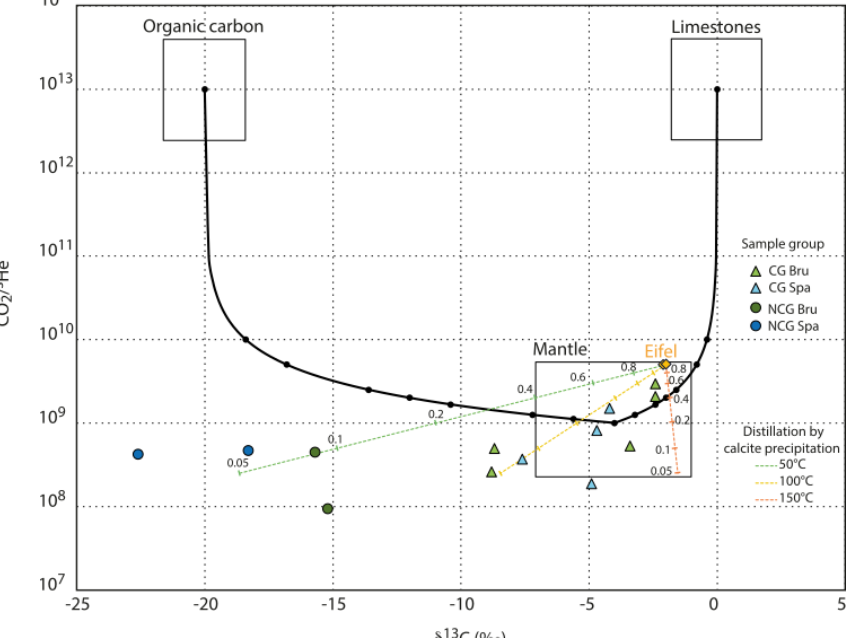
Figure 5. CO 2 / 3 He ratios vs. δ 13 C values for groundwater samples in relation to mixing between the mantle, carbonate and organic CO 2 endmembers based on Sano and Marty (1995). CGB = carbogaseous water from the Bru area, CGS = carbogaseous water from the Spa area, CGE = carbogaseous water from the Eifel area, NCGB = non-carbogaseous water from the Bru area, and NCGS = non-carbogaseous water from the Spa area. Gas Eifel composition from Marty et al. (2020). VQ , SQ and MORB are depicted from the values presented in Marty et al. (2020). All CO 2 -rich groundwater samples fall in or close to the mantle range. Non-CO 2 -rich groundwater samples present much lighter C isotopic composition. The impact of calcite precipitation at three temperature (50, 100 and 150 ◦ C) is modeled assuming an open system Rayleigh distillation, following Ray (2009) and Barry et al.